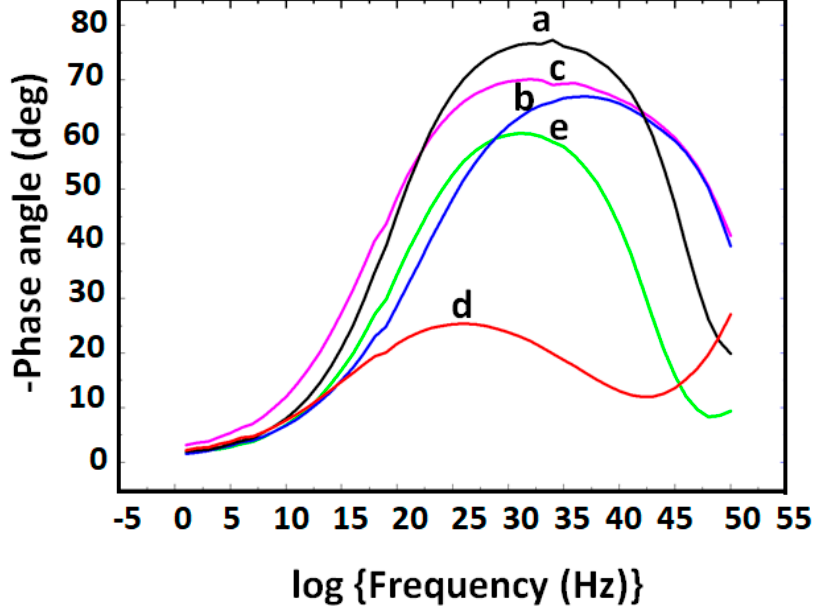
Figure 10. The electrochemical impedance spectroscopy (EIS) Bode phase plots for ( a ) GCE, ( b ) GCE PDMA, ( c ) GCE PDMA–PVS, ( d ) GCE PDMA–PVS–Ag 0 and ( e ) GCE PDMA–PVS–Ag 0 1 μ M 5 ′ -thiol MC-LR-aptamer (SH-Apt).